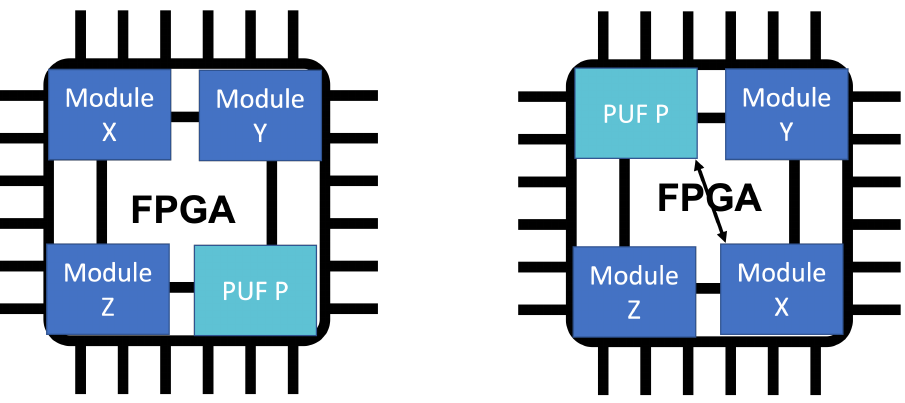
Figure 5. By changing the position of a PUF on an FPGA, we can generate different PUFs with unique and uncorrelated CRPs [6].